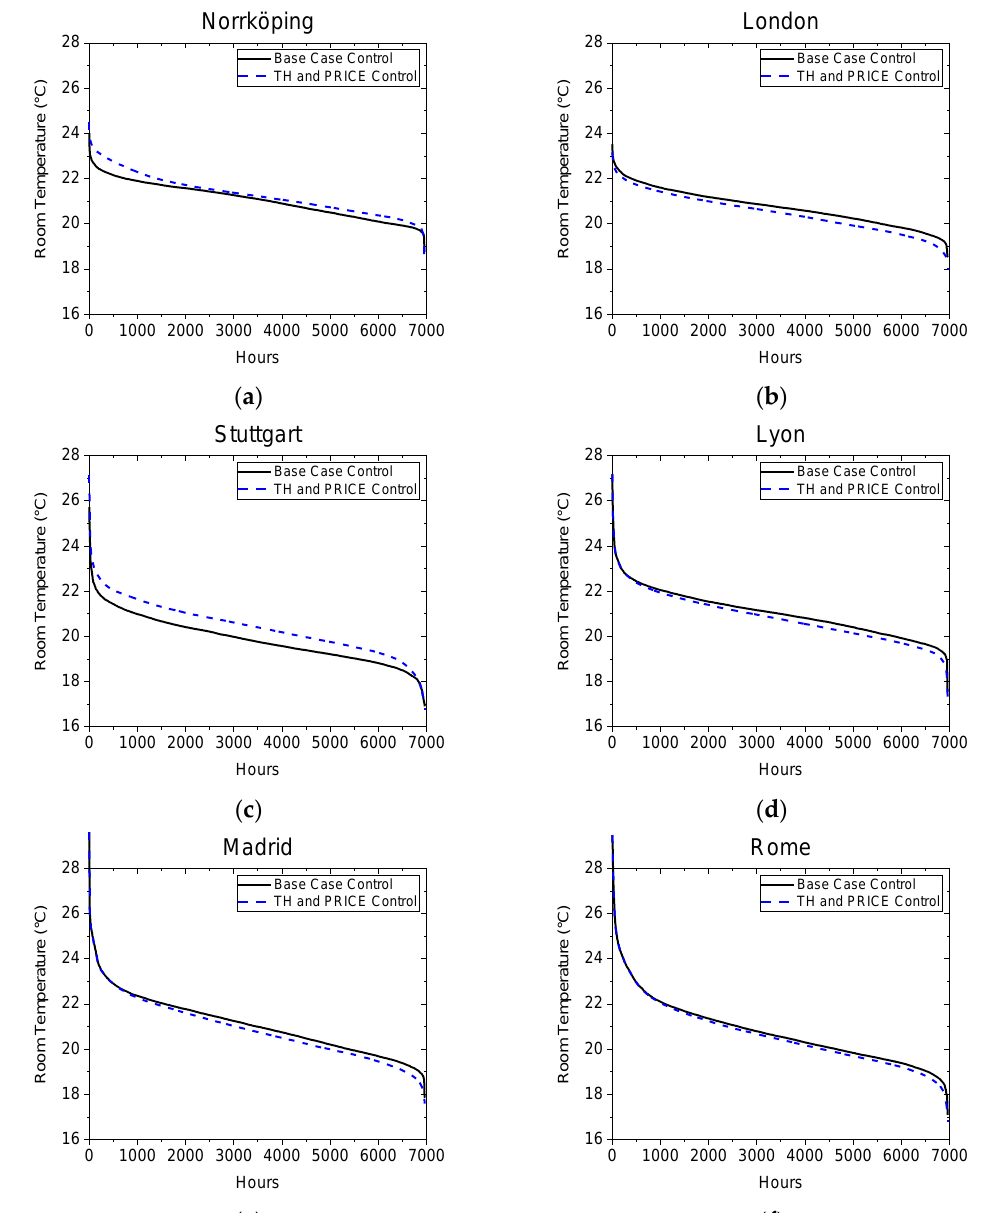
Figure 11. Duration curve of hourly temperature of the living room during the heating season for the case with PRICE and TH control for the six examined locations. ( a – f ) shows the duration curve respectively for each of the six examined locations.